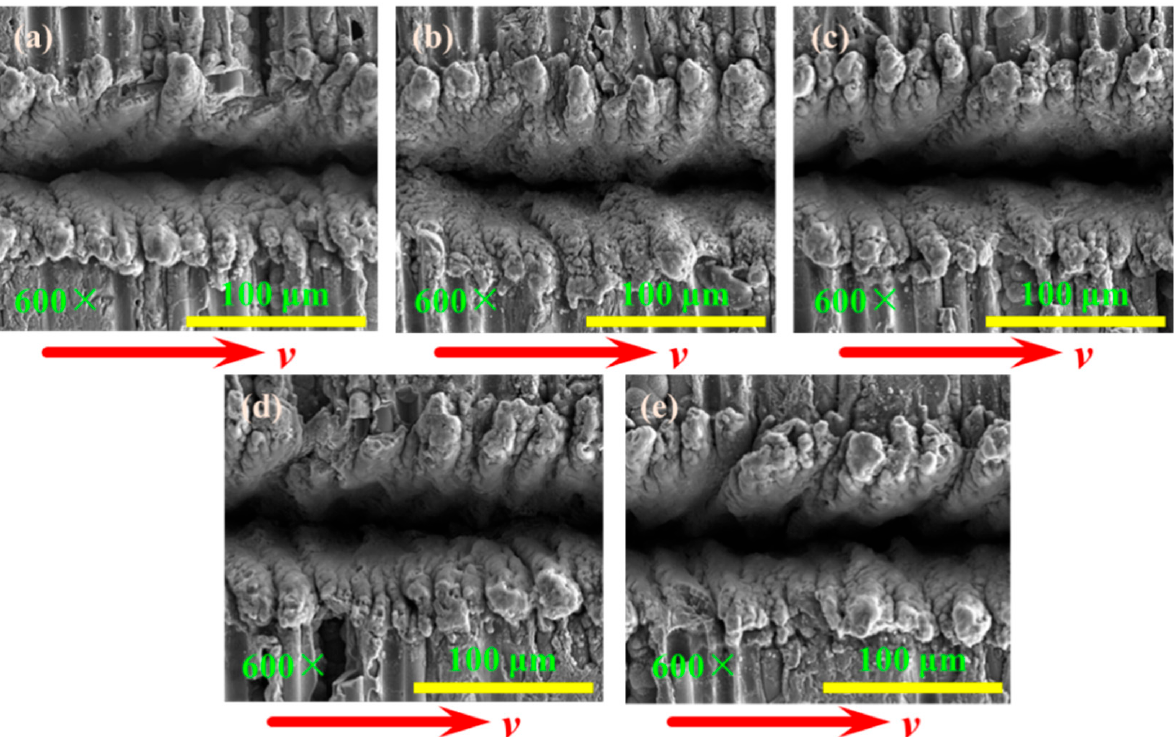
Figure 14. The grooved morphologies corresponding to different laser powers: ( a ) 14 W; ( b ) 15 W; ( c ) 16 W; ( d ) 17 W; ( e ) 18 W.